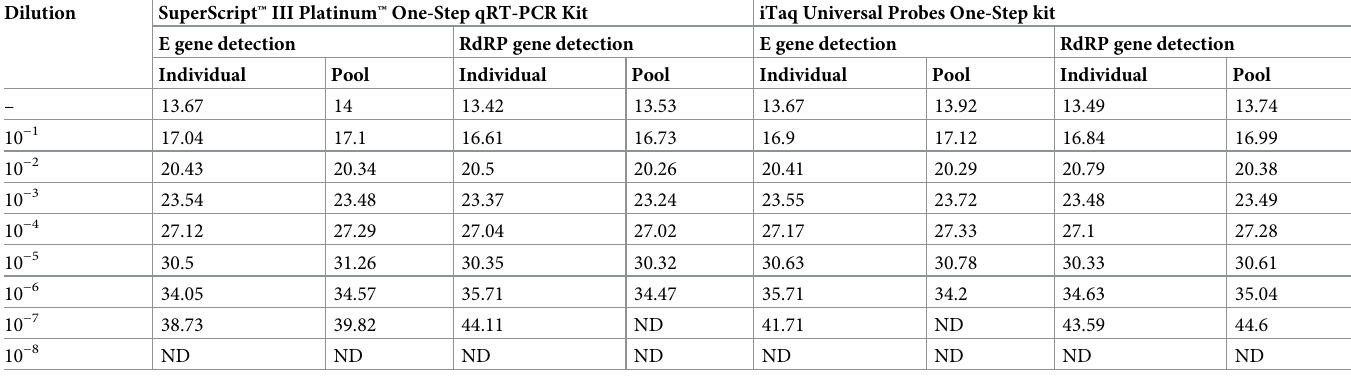
Table 1. Comparison of individual test Ct value with pool Ct value using 10-fold serial dilutions of a positive nasopharyngeal sample, and 2 different RT-PCR kits for the detection of SARS-CoV-2 E and RdRP genes.